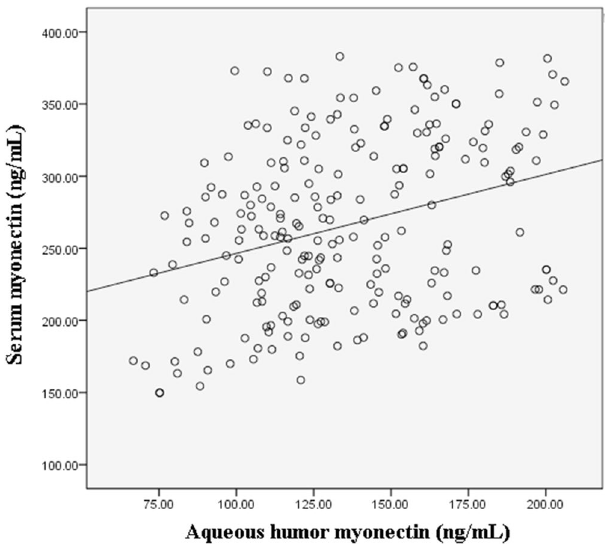
Figure 2. The Scatter plot showing the association between serum and aqueous humor